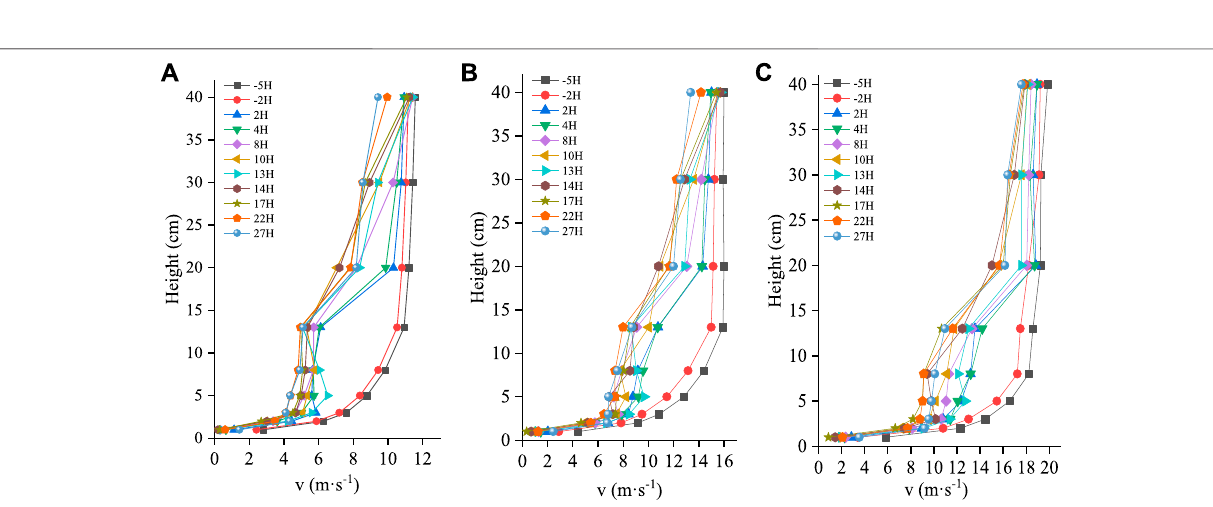
Frontiers in Environmental Science |